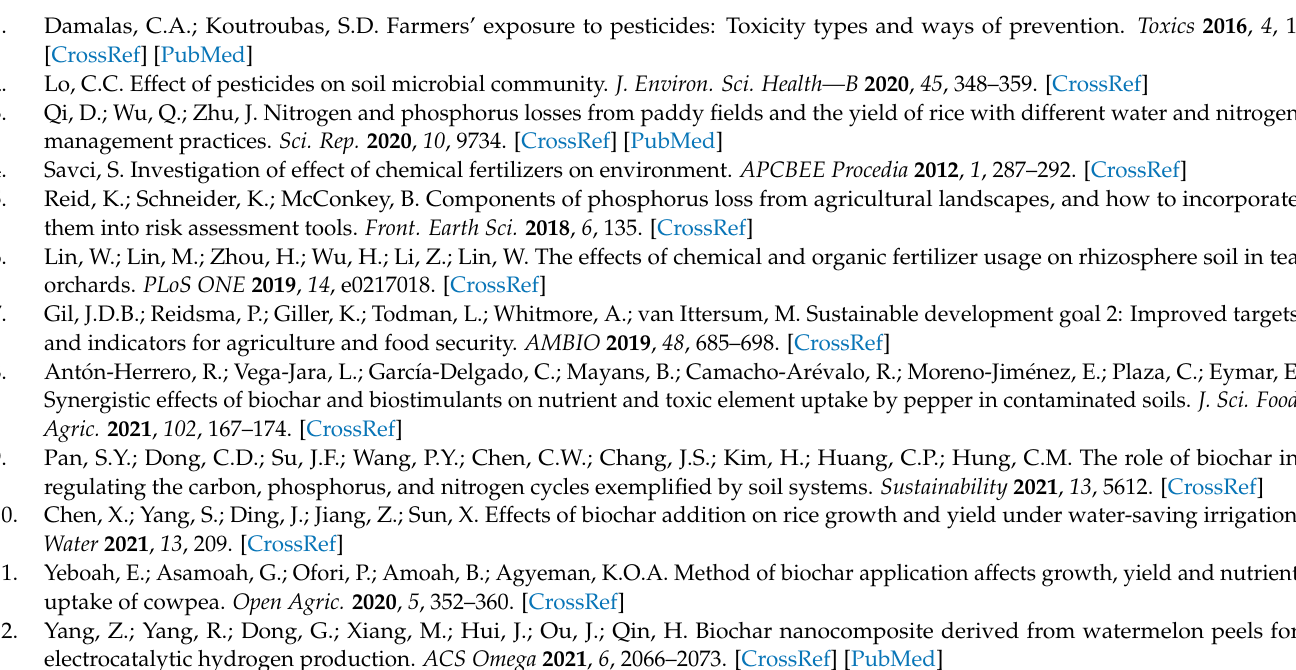
Table S1: Elemental analysis of bentonite nanoclay by by inductively coupled plasma optical emis- sion spectrophotometry (ICP-OES); Table S2: Elemental analysis of bentonite nanoclay by energy dispersive X-ray spectroscopy (EDX); Table S3: pH, conductivity and cation exchange capacity (CEC) of biochar; Table S4: Content of phosphorus (P) and nitrogen (N) in biochars; Table S5: Content of P and N in soil substrate and fertilizer; Table S6: Changes in soil pH during the 1st tomato experiment, 2nd tomato experiment and watermelon